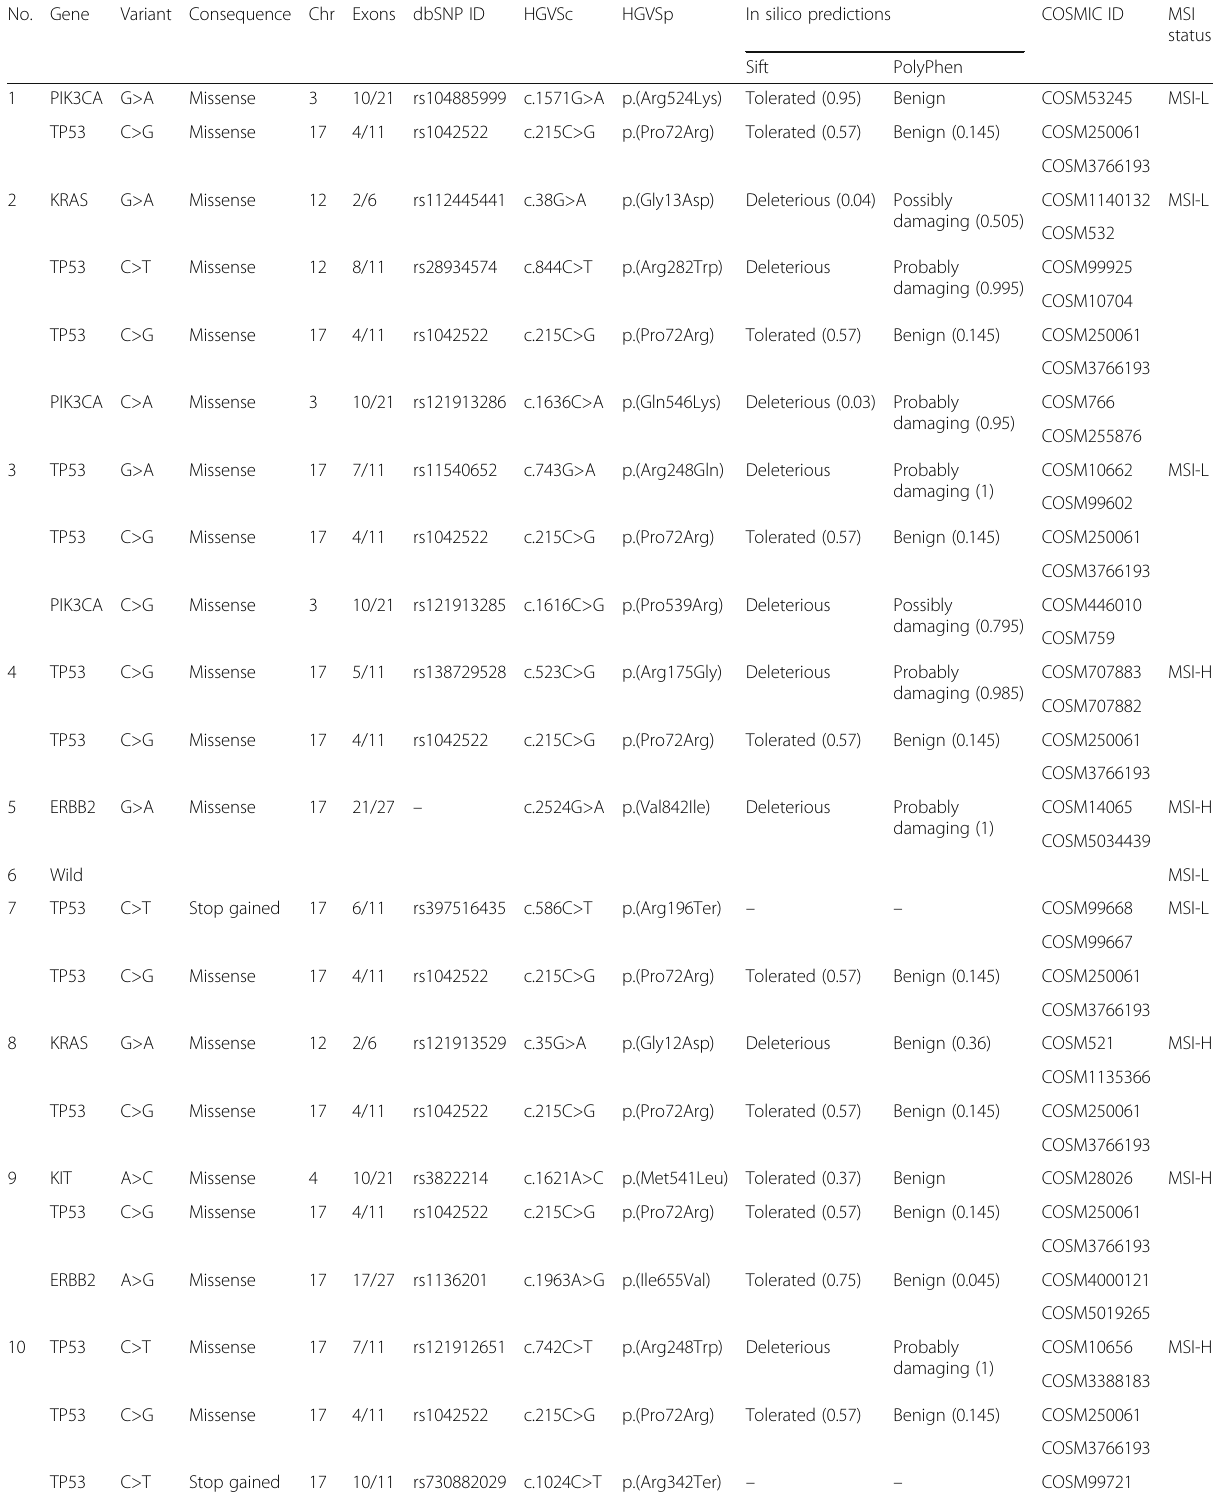
Table 2 Patients ’ mutational